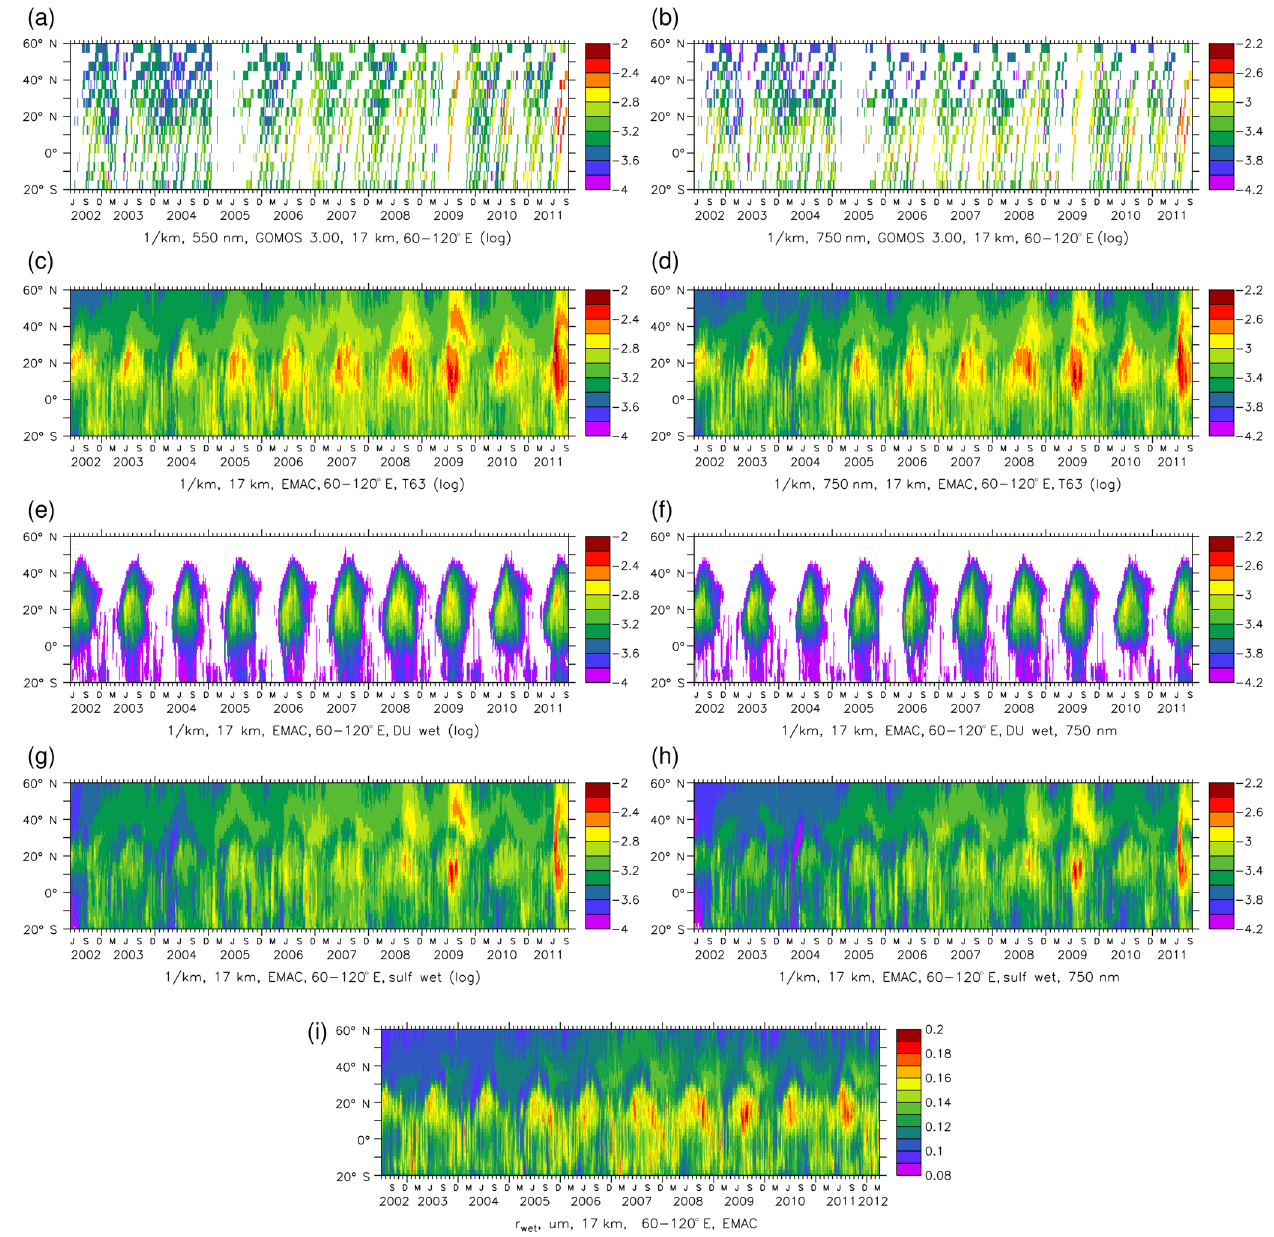
Figure 2. Observed (a, b) and simulated ( c, d , EMAC T63L90) extinction in the Asian sector (60–120 ◦ E, 20 ◦ S–60 ◦ N) for 550nm (a, c) and 750nm (b, d) . Contribution of wet dust (e, f) and wet sulfate (g, h) to extinction for 550nm (e, g) and 750nm (f, h) . (i) Median wet radius in accumulation mode (for effective radius multiply by